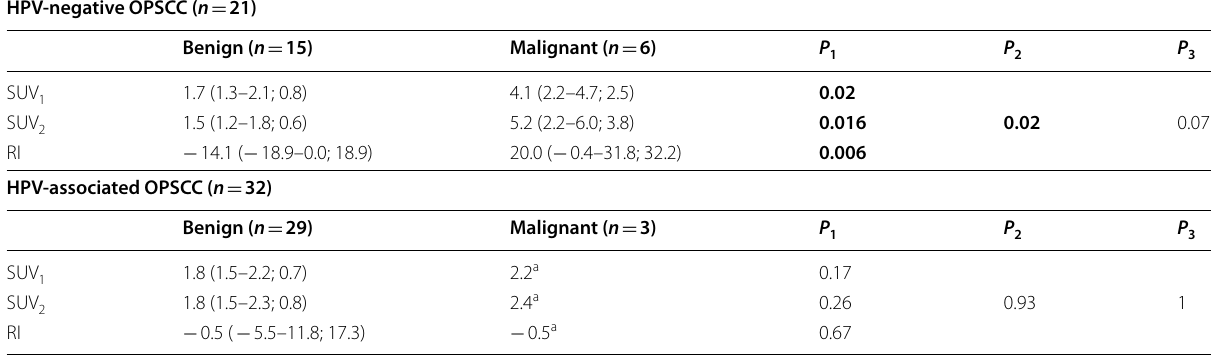
Bold was used to indicate statistical significant P values